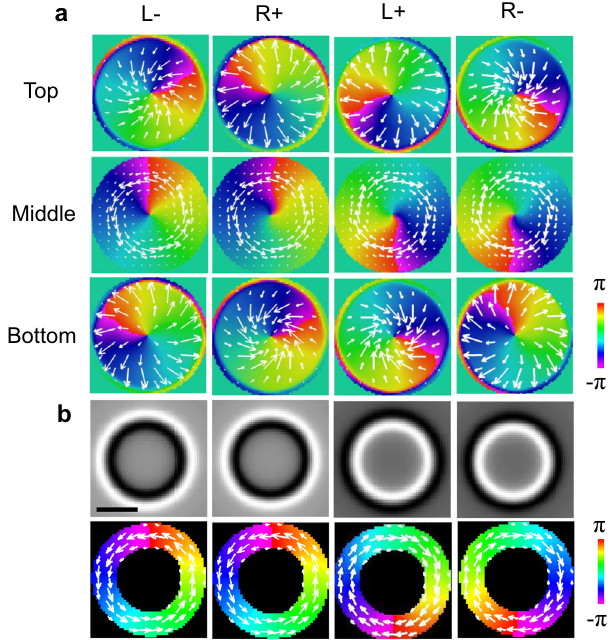
Fig. 1 | Simulation of skyrmion bubbles. a Magnetization characteristic at the surfaces and centers of different skyrmion bubbles. b The simulated 300 μ m over- focused Lorentz TEM images and the recovered in-plane magnetization map from the simulated Lorentz TEM images (the color denotes the direction of the local induction). The contrast below 5% of the maximum magnitude is masked in the magnetization mapping to fi lter the artifacts induced by the regularization para- meter in the TIE. The scale bar is 50nm. The polarity and vorticity determine the chiralityoftheskyrmionbubbleasL+( p +, w +),L − ( p − , w − ),R+( p +, w − )orR − ( p − , w